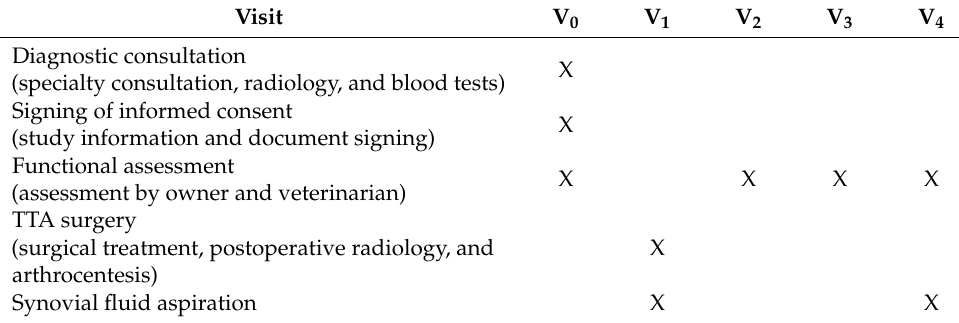
Table 1. Summary of experimental